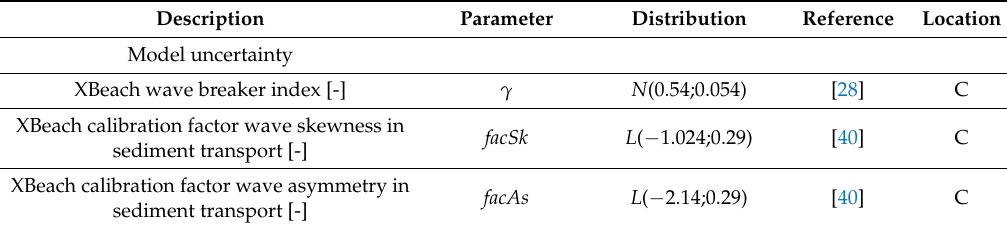
Table 1. Stochastic variables as used in the probabilistic calculations and their accompanying probability distributions.